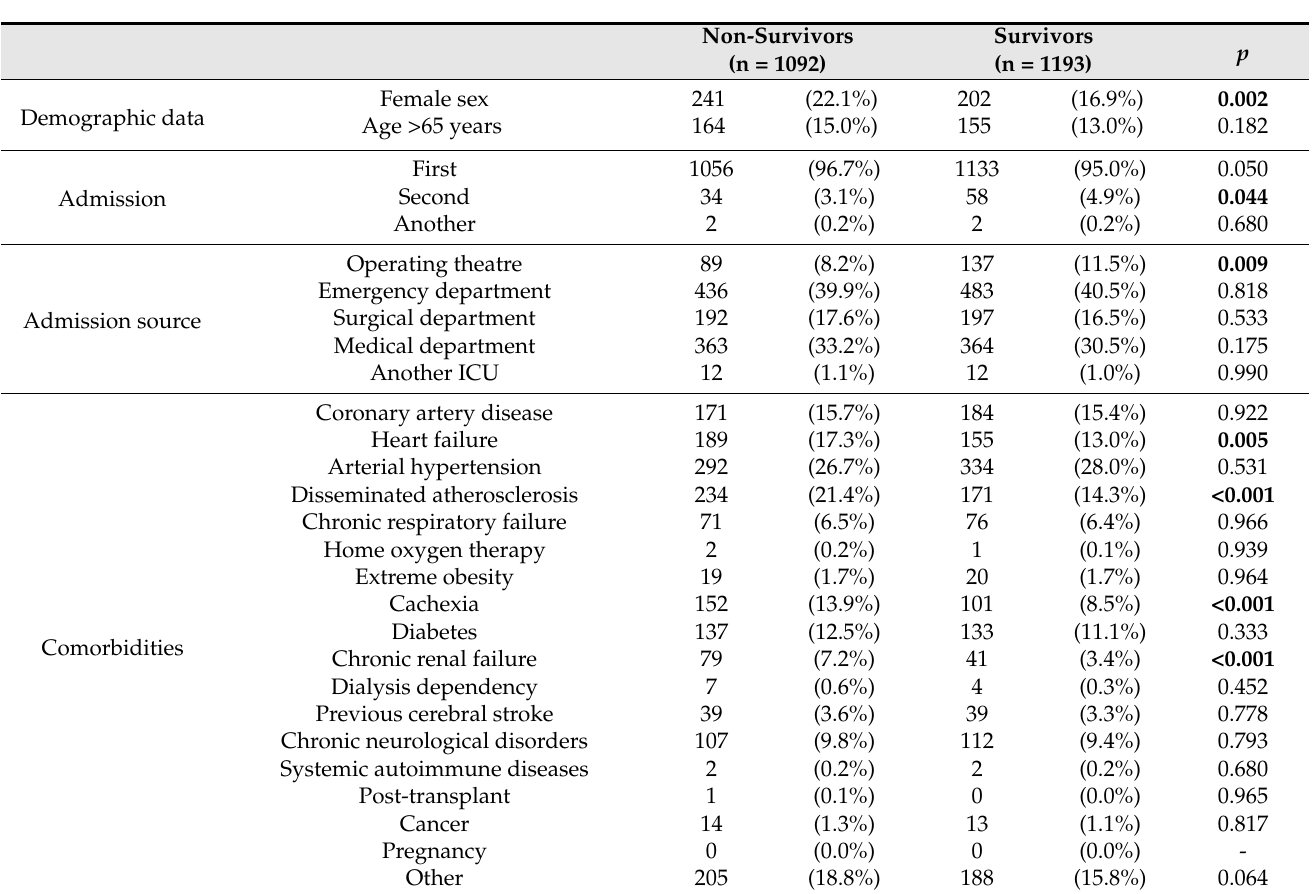
Table 4. Demographic data, admission source, and medical status at ICU admission among patients with AD—comparison of non-survivors and survivors.